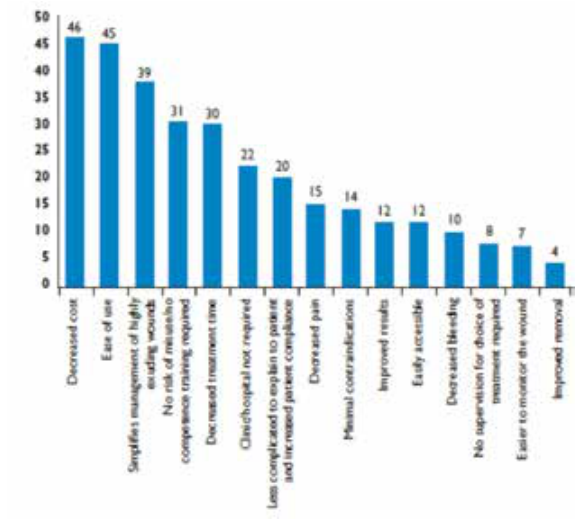
Figure 2: Benefits to the clinician offered by replacement of NPWT with HRT-dressing